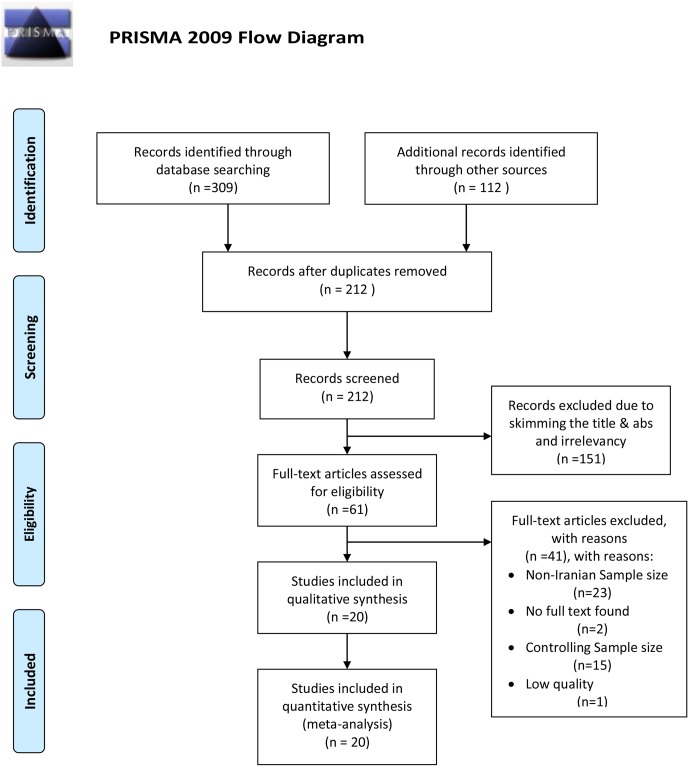
A flow diagram following the PRISMA (depicted by MH-YK).From: Moher D, Liberati A, Tetzlaff J, Altman DG, The PRISMA Group (2009). Preferred Reporting Iterns for Systematic Reviews and Meta-Analyses: The PRISMA Statement. PLoS Med 6(7): e1000097. doi:10.1371/journal.pmed1000097
For more information, visit
www.prisma-statement.org.